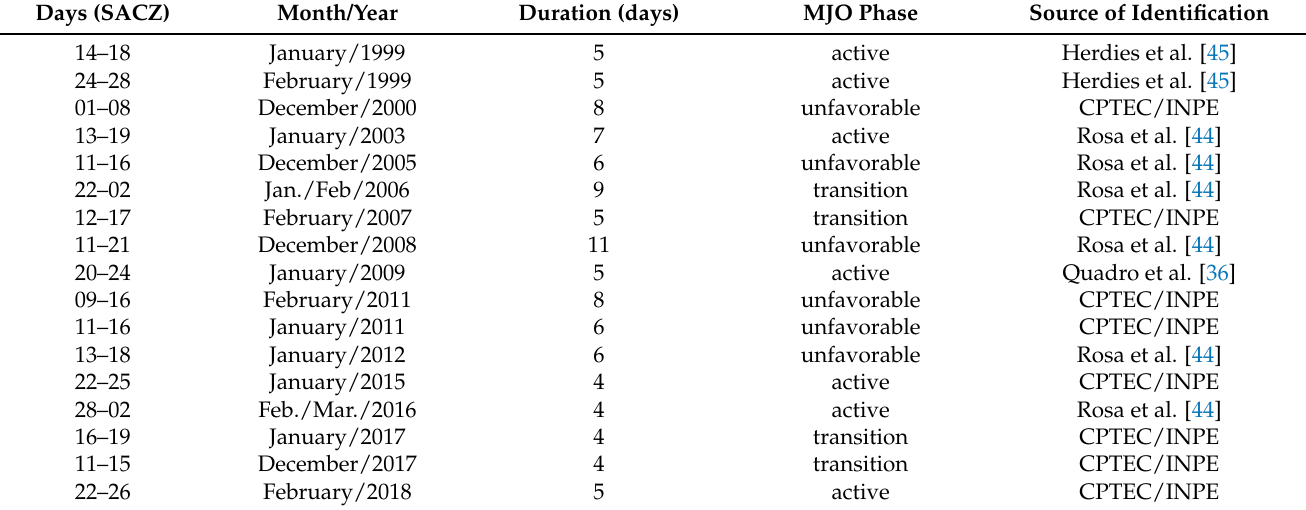
Table 1. Identification of the 17 SACZ events with their respective MJO phase and each source of